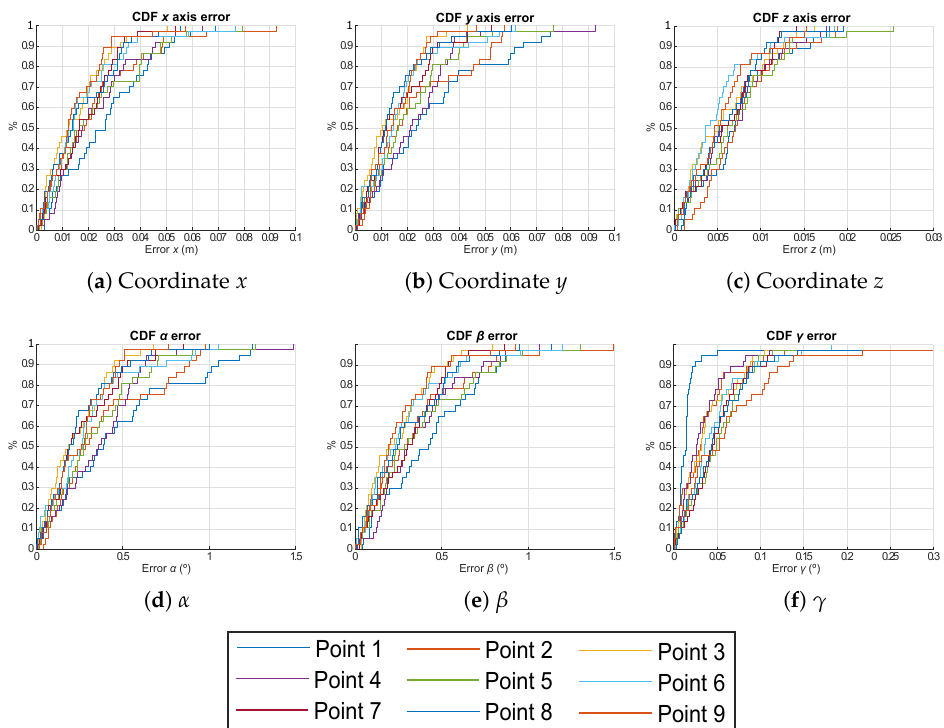
Figure 8. CDF of the absolute pose errors for the nine representative points defined in Table 1 for the case of using the IPPE algorithm.